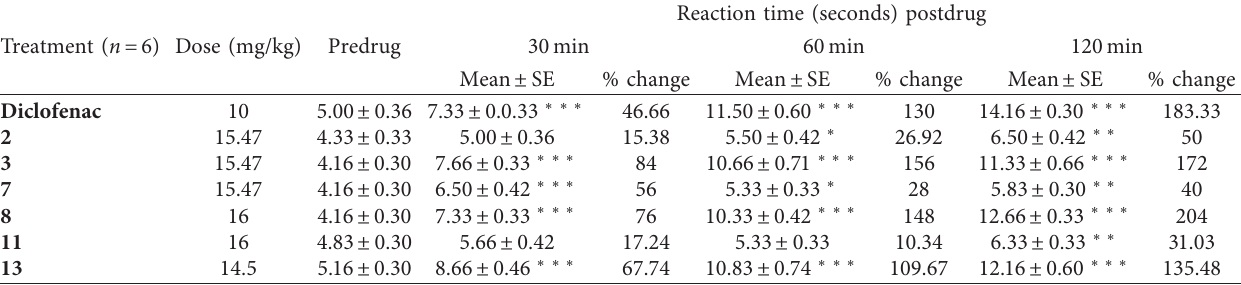
Table 2: Analgesic effect of compounds on hot plate reaction time in mice.